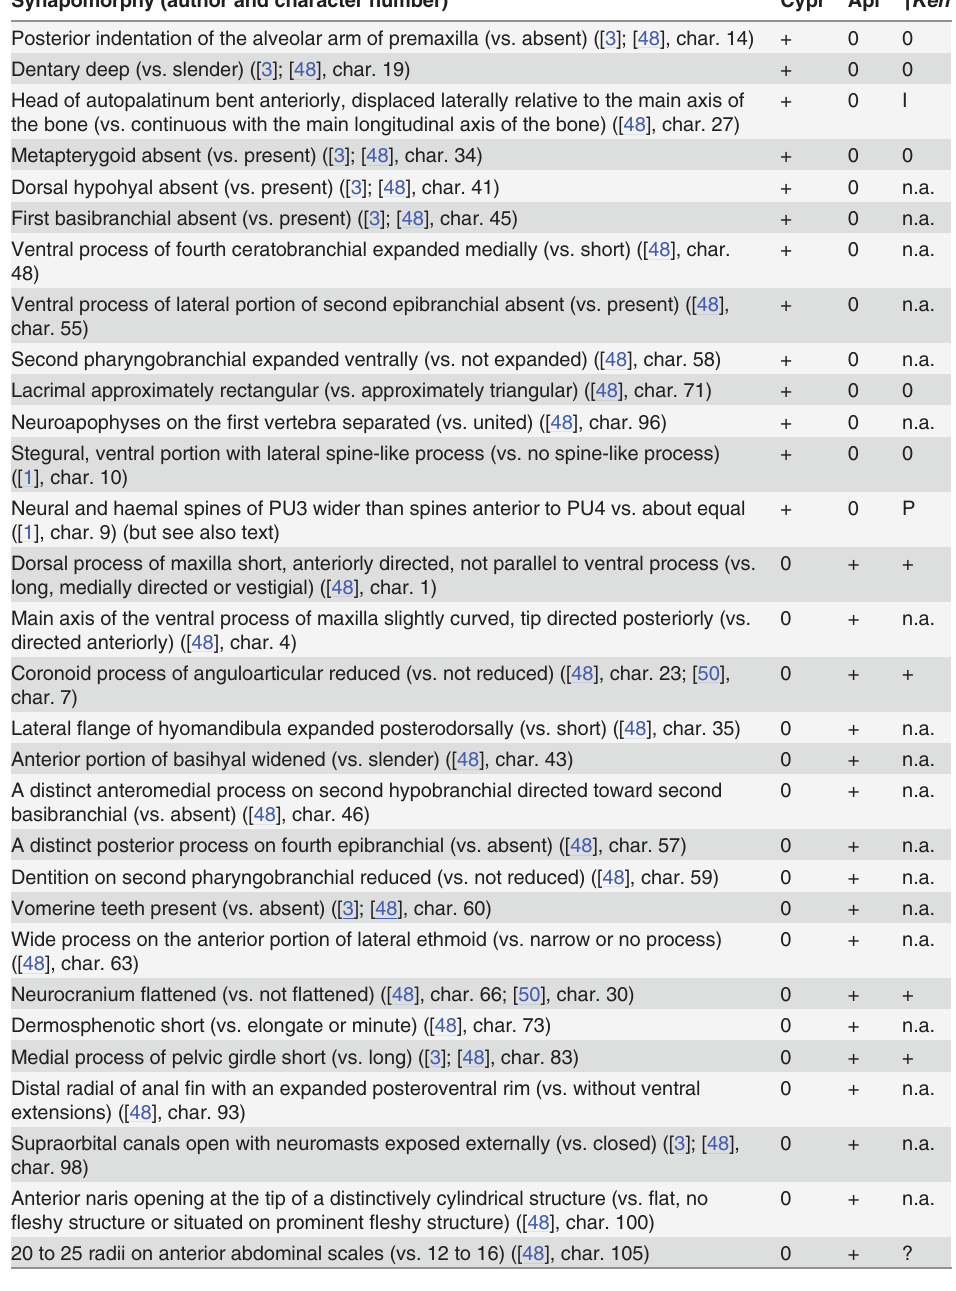
+ 0 I + 0 n.a. + 0 n.a. + 0 0 + 0 P 0 + + 0 + n.a. 0 + + 0 + n.a. 0 + n.a. 0 + n.a. 0 + n.a. 0 + n.a.